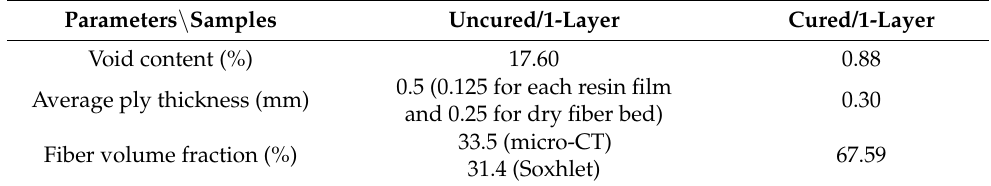
Table 5. The evolution of void content, average ply thickness, and fiber volume fraction for each sample. Parameters \